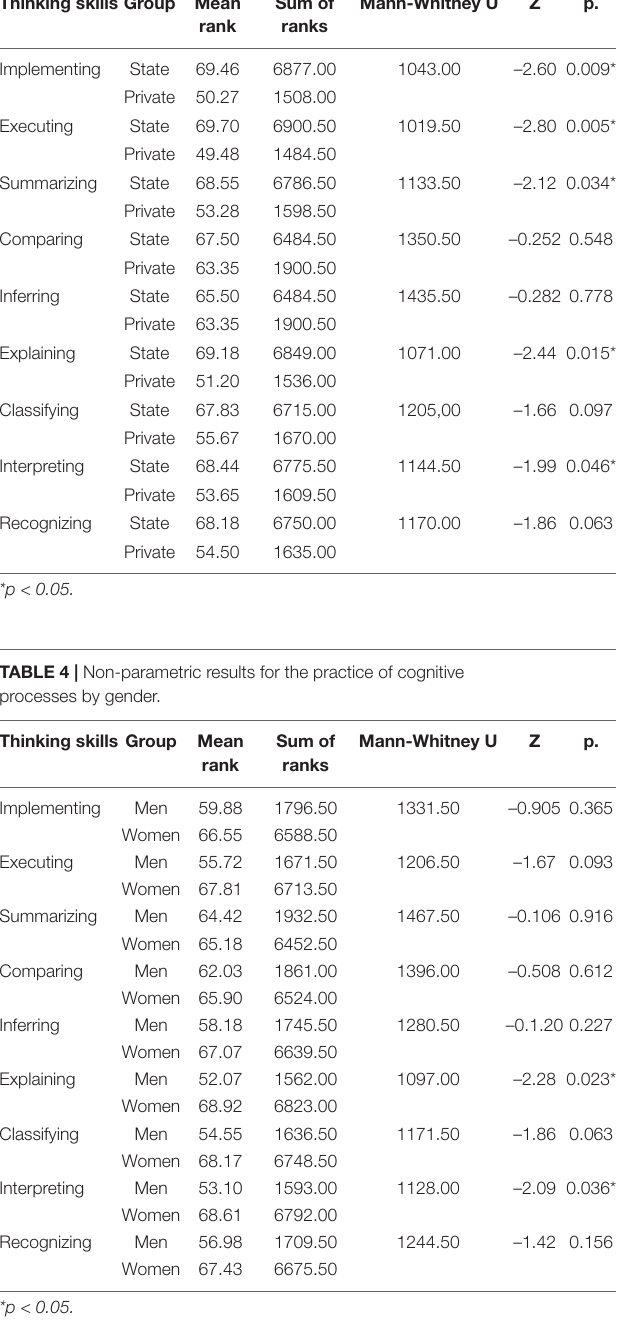
TABLE 3 | Non-parametric results of the development of cognitive processes according to the type of school where they work. Thinking skills Group Mean Sum of Mann-Whitney U Z p. rank ranks